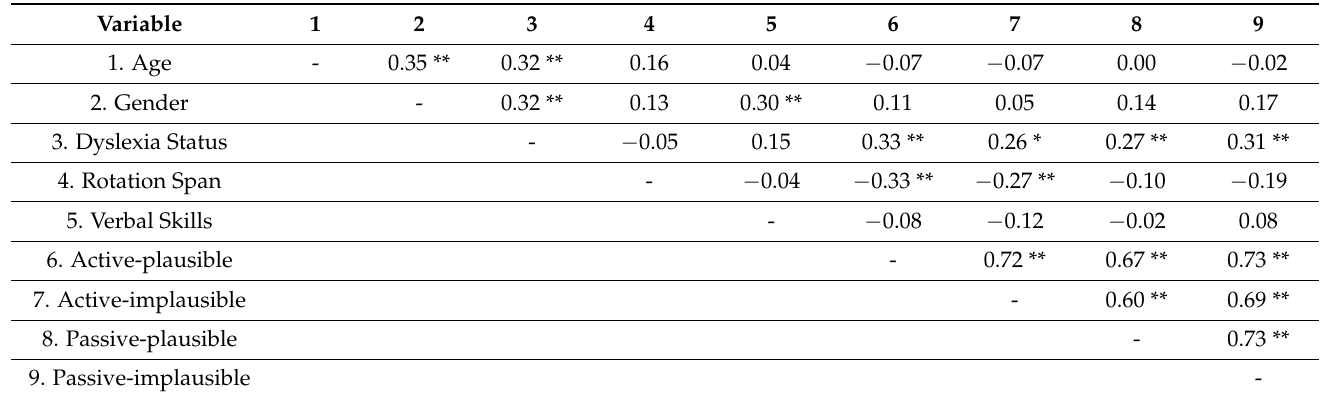
Table 4. Bivariate correlations between demographics, working memory, verbal skills, and total reading time on critical